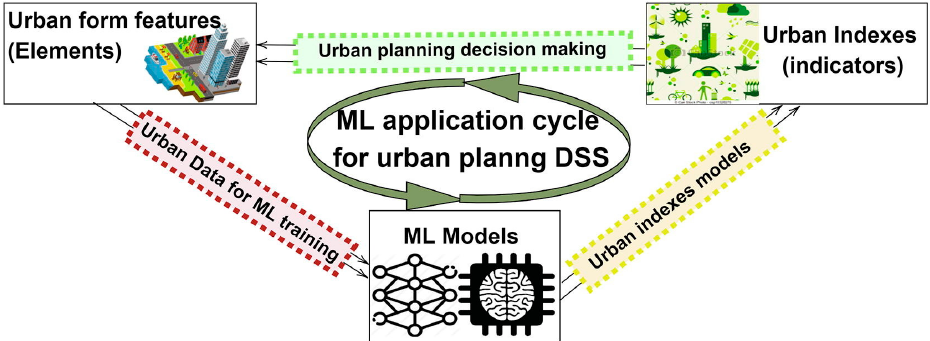
Figure 7. A cycle of ML application for urban form decision support system [35].